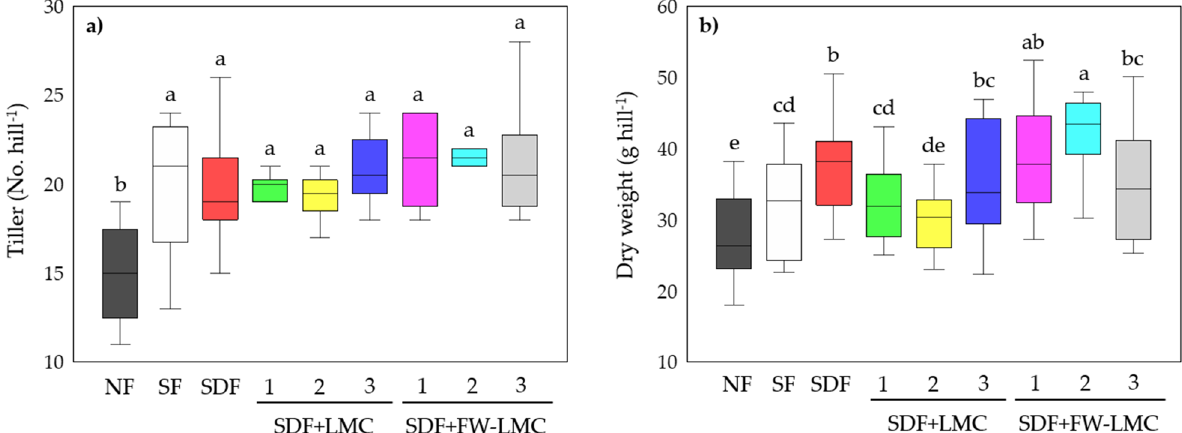
Fig. 1 Comparison of tillers (per hill) and shoot growth and at the tillering stage affected by varying types and rates of fertilization. Rice plants were taken with three replications (3 plants/repeat). Different letters mean a statistical significance at 0.05 (n